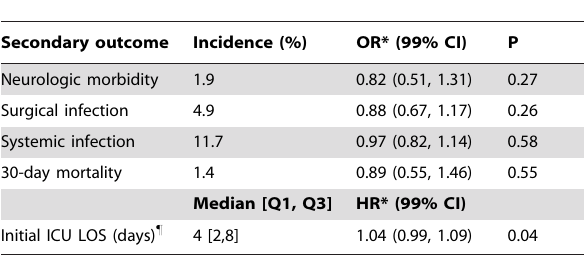
Table 3. The associations between serum vitamin D concentration and secondary outcomes among 426 cardiac surgical